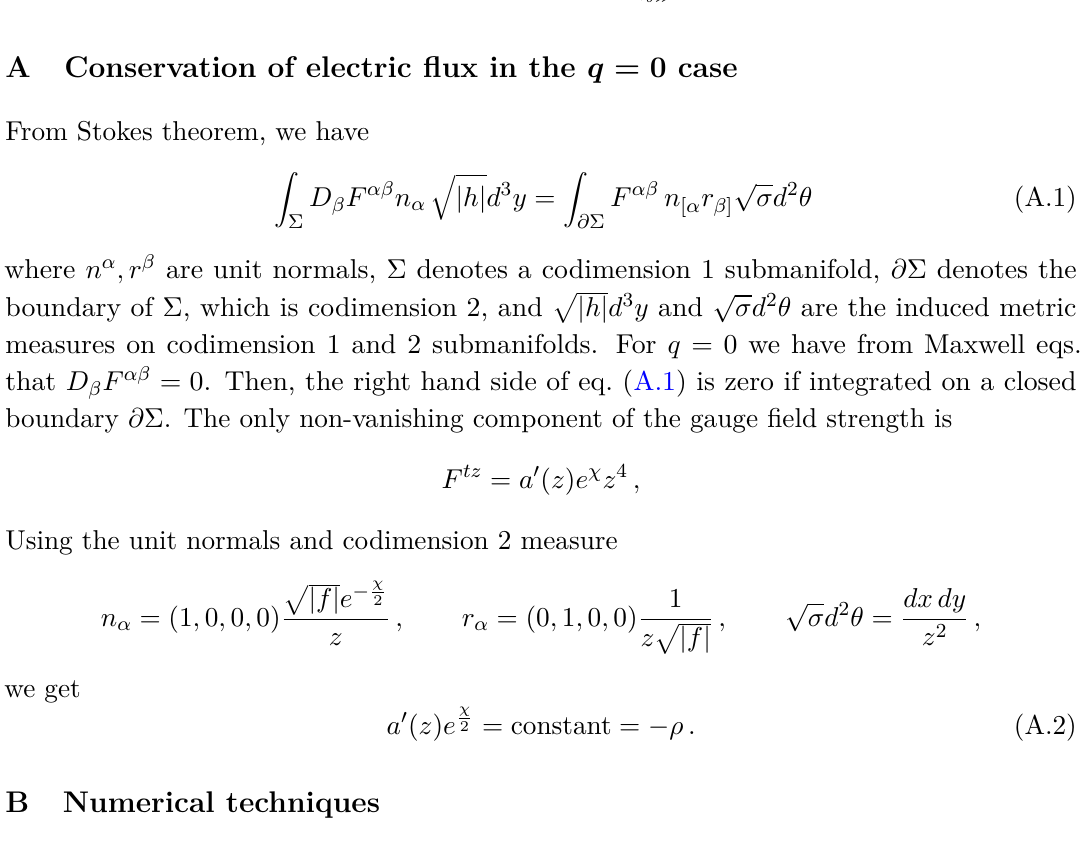
(cid:12) (cid:12) = const . + 0 . 88 1 log φ 0 (cid:12) dt b µ t b (cid:29) 1